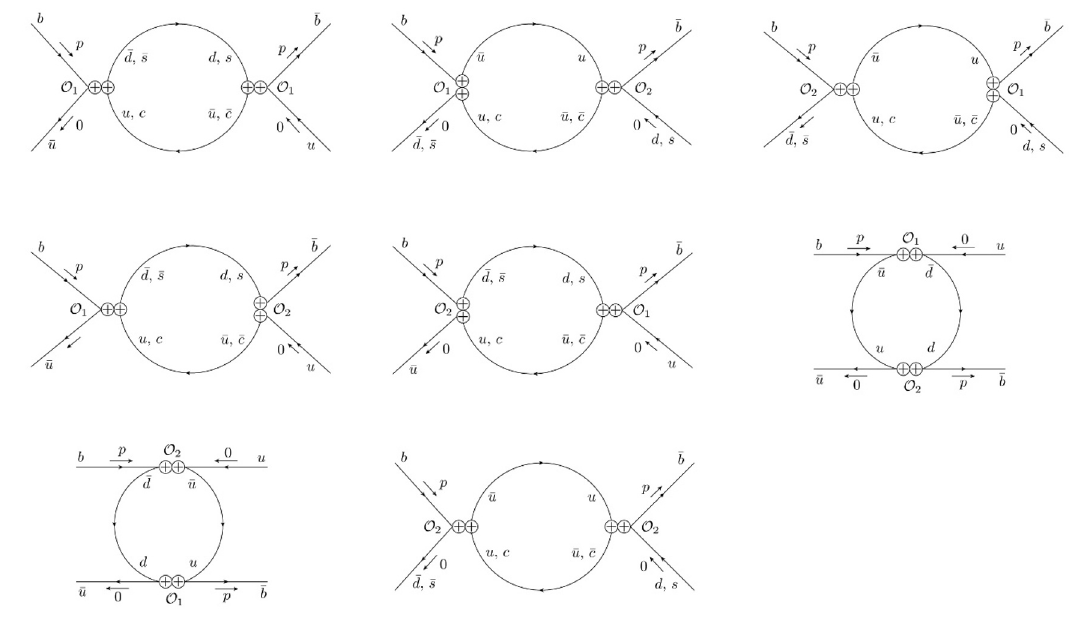
Figure 2 . One loop diagrams contributing to the tree level matching coefficients of four-quark operators in the HQE of the B -hadron non-leptonic decay